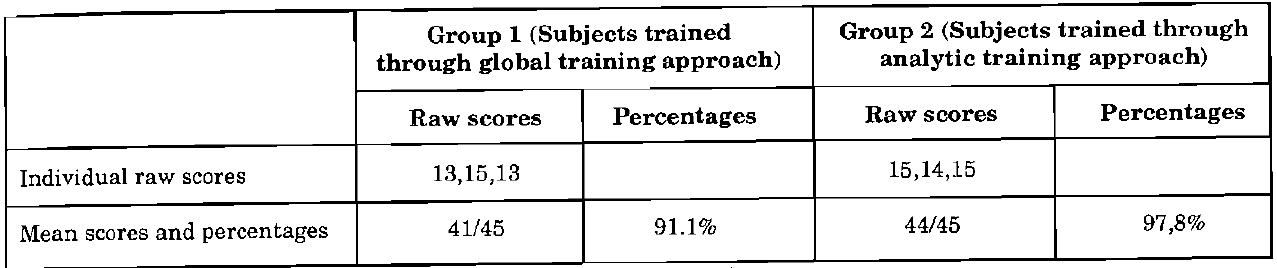
TABLE 6. Results obtained during the re-evaluation procedure